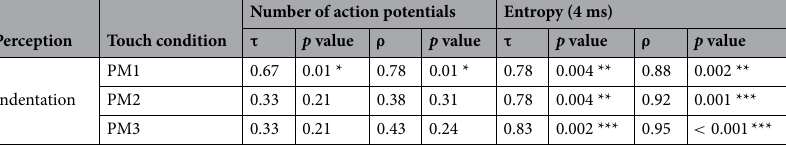
Table 2. Statistical analysis reveals the significant correlations between the rank of indentation magnitude of the surface geometry and Shannon entropy value. *, **, *** denote p < 0.05, 0.01, 0.001,